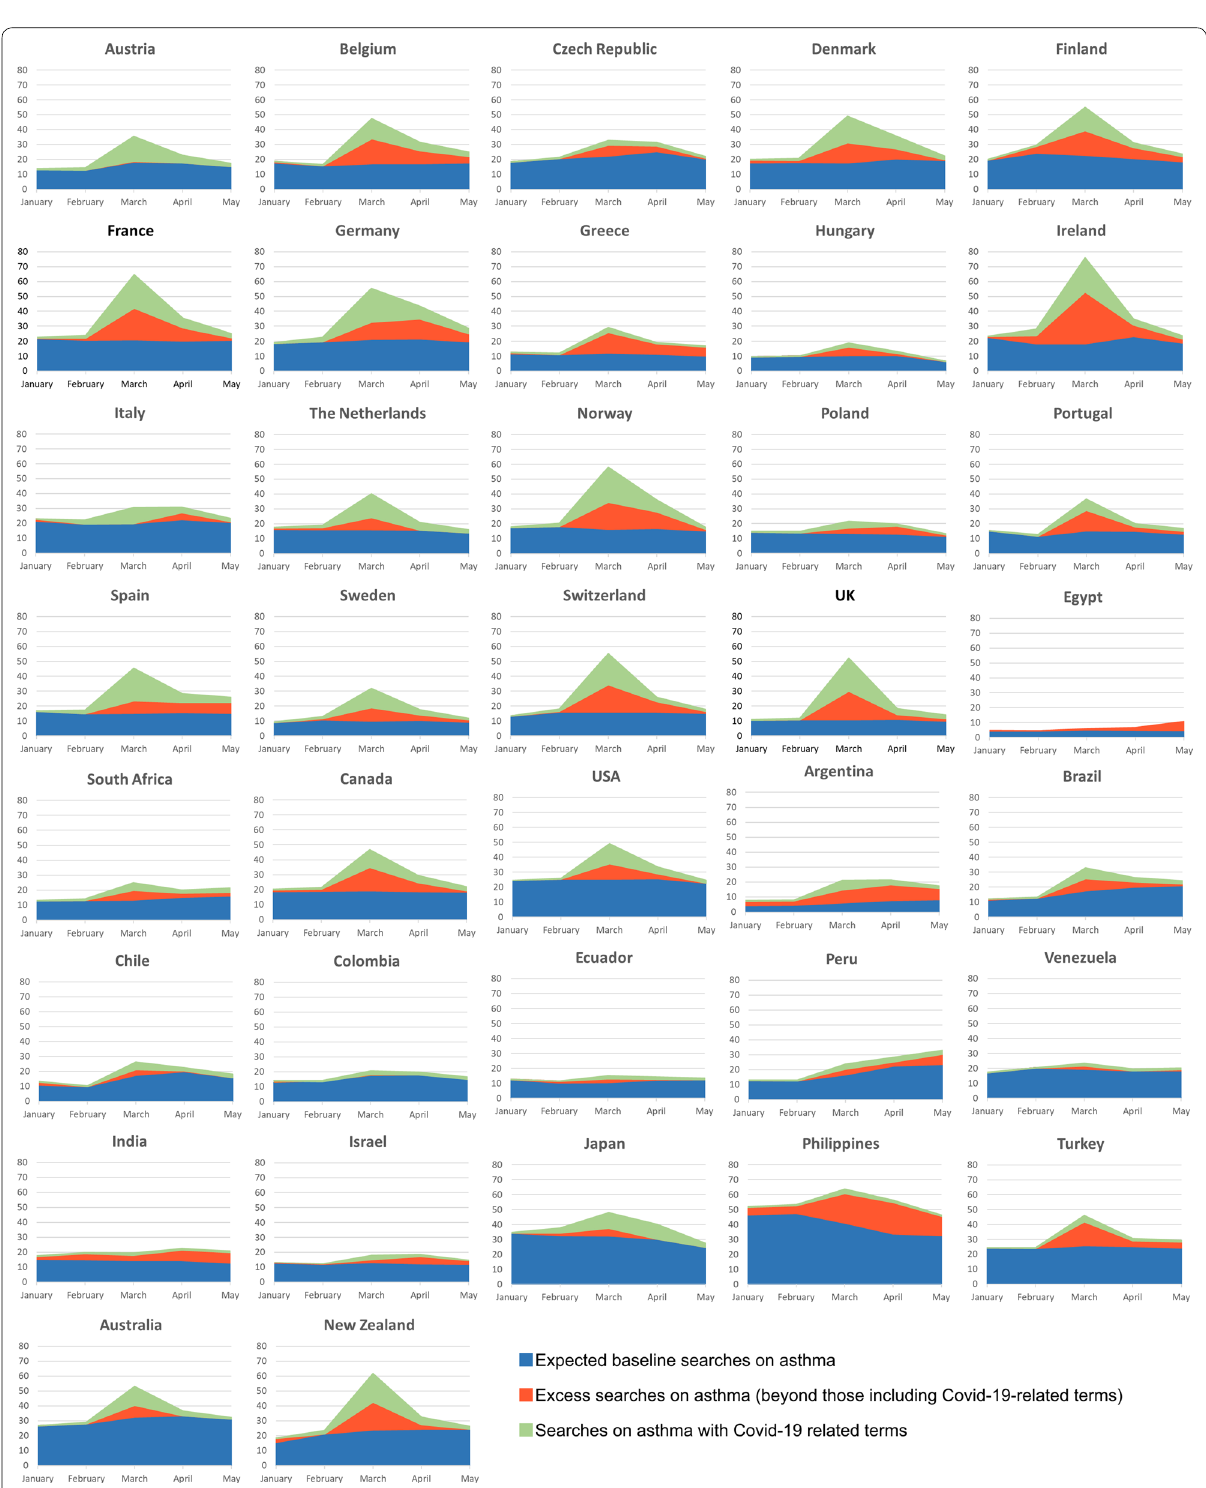
Fig. 2 Monthly average Google Trends for “asthma” (as a disease) between January and May of